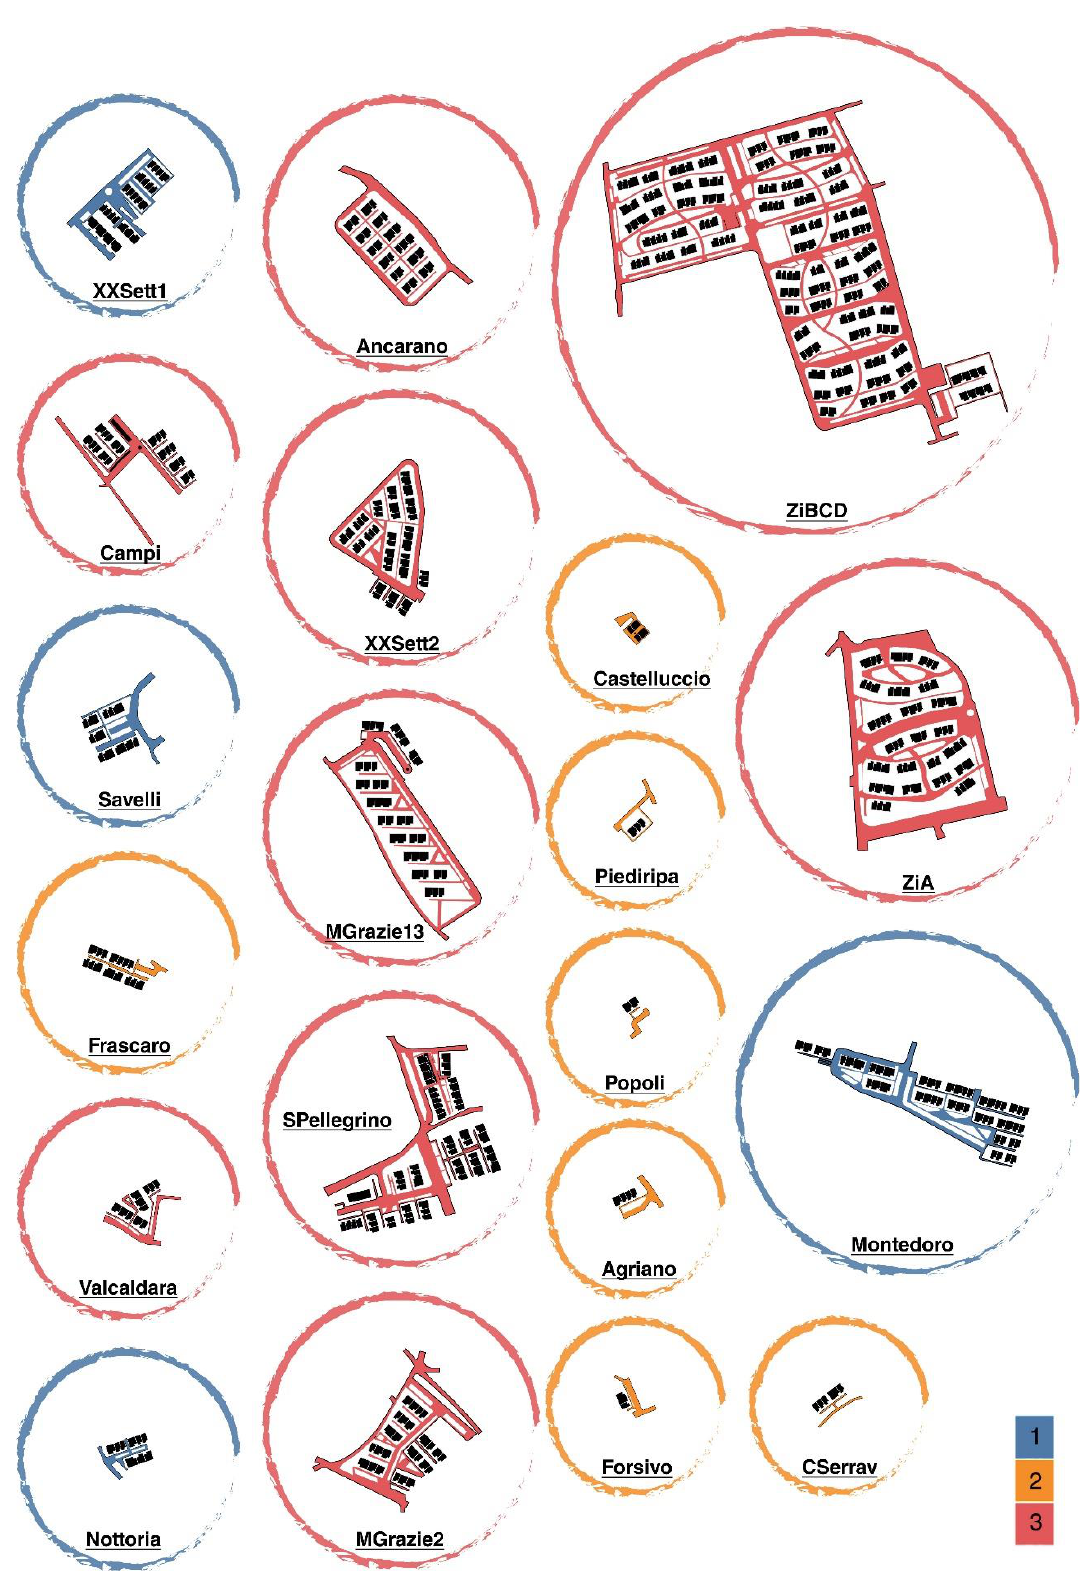
Figure 9 Norcia TH sites layouts summative clustering result